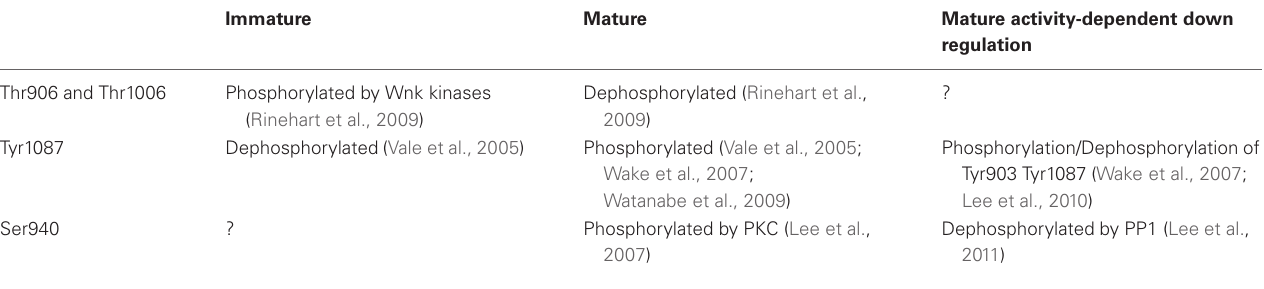
Table 1 | Phosphorylation/dephosphorylation states of KCC2 at immature or mature stages of development and in conditions of increased